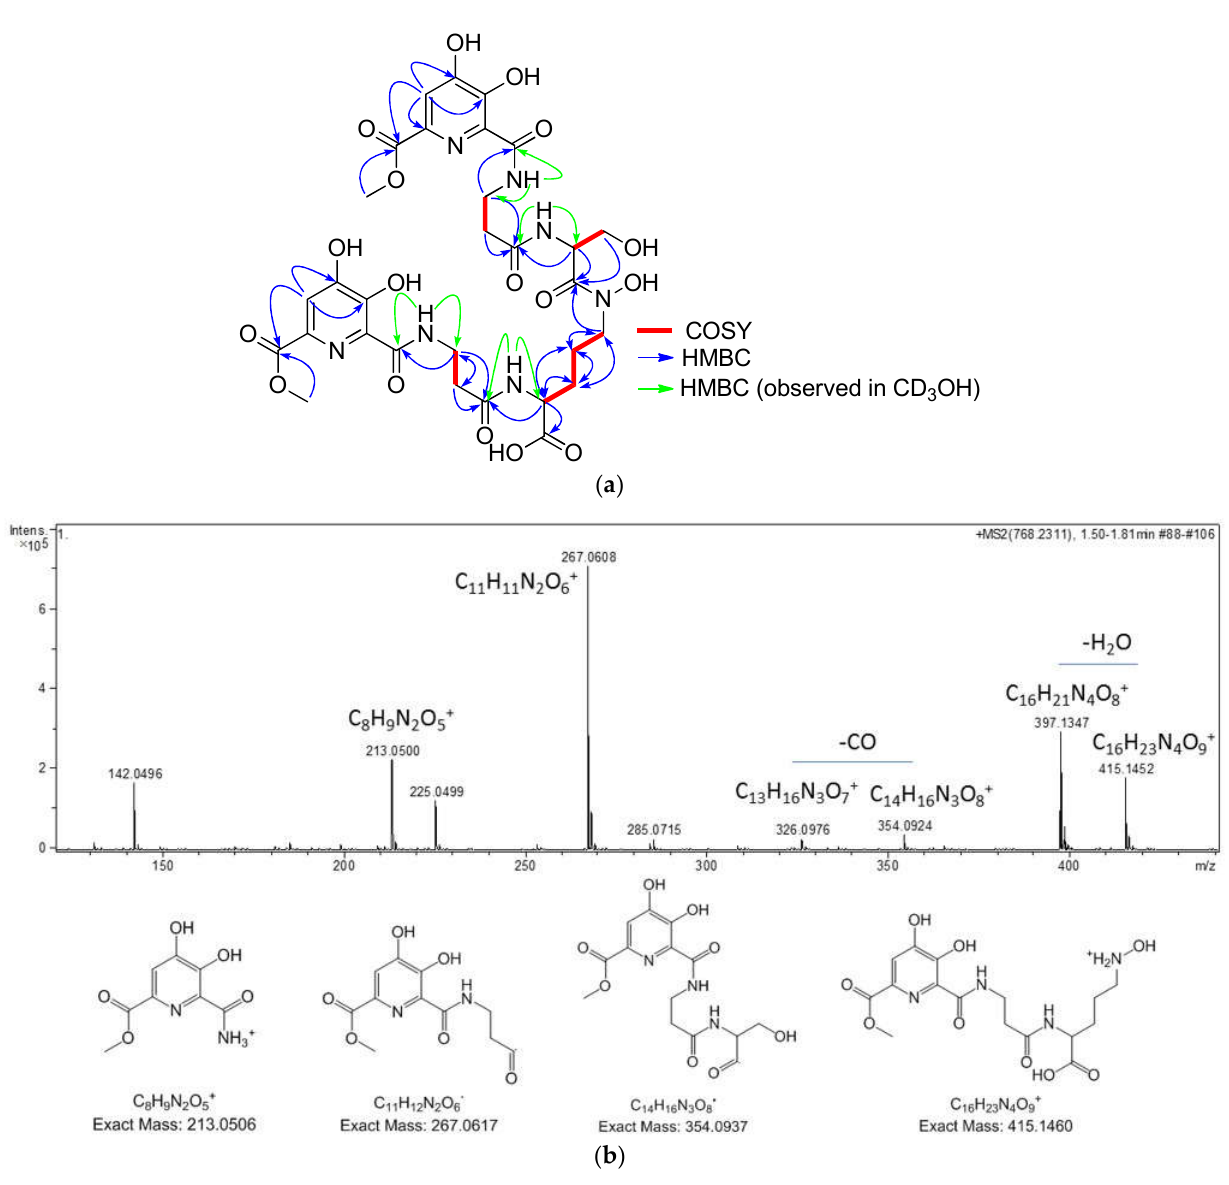
Figure 3. ( a ) Key COSY and HMBC correlations observed in the structure of kribbellichelin A ( 1 ). ( b ) MS/MS fragmentation of kribbellichelin A ( 1 ).